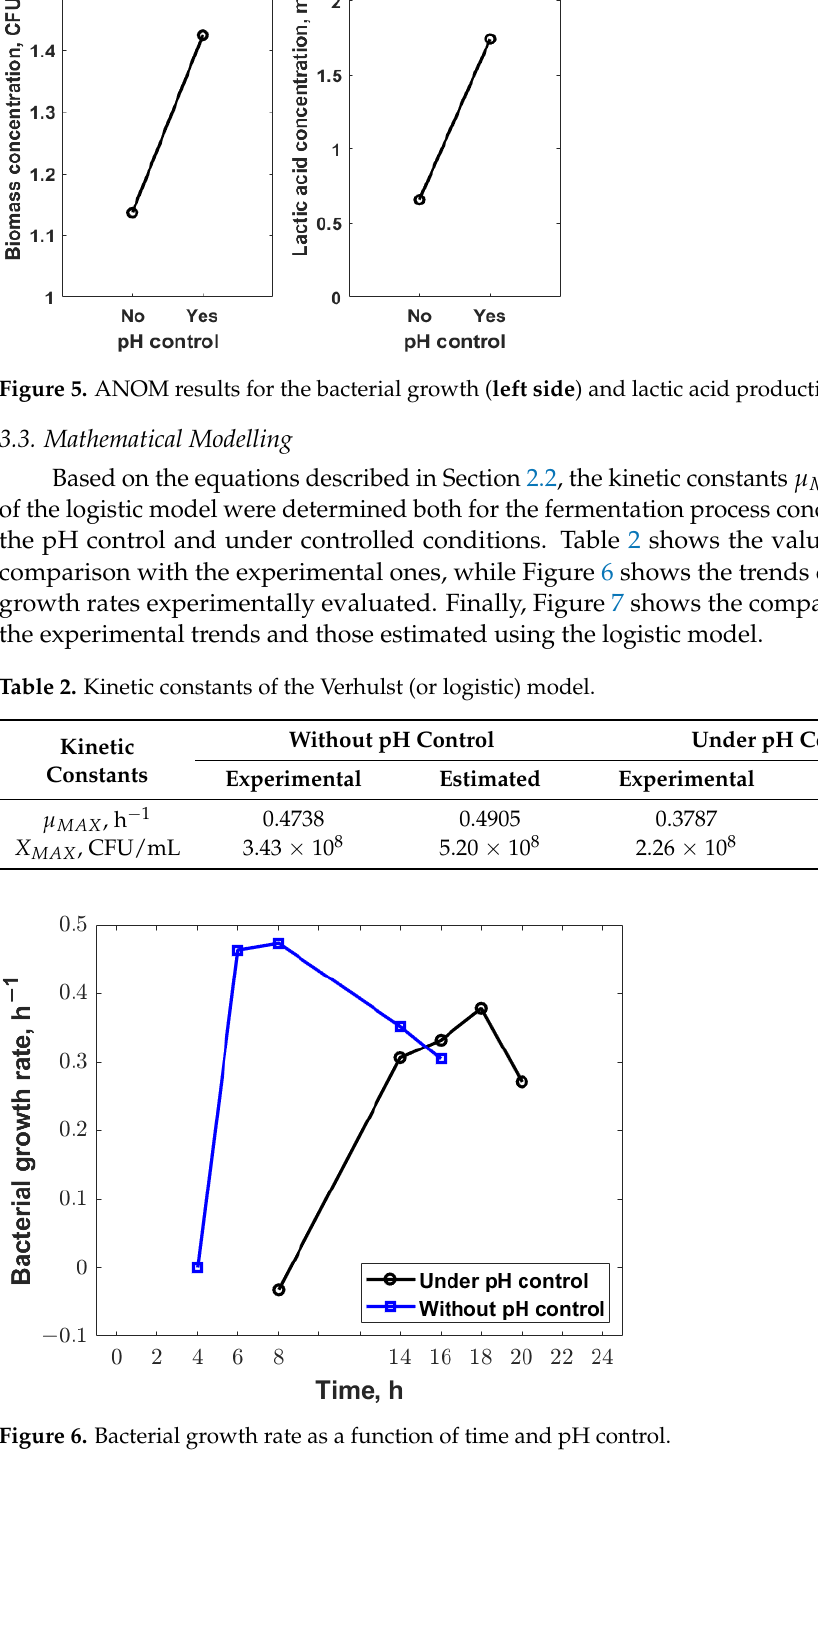
( b ) Figure 7. Trends of the bacterial growth rates estimated using the logistic model: ( a ) without and ( b ) under pH control. As can be seen from Error! Reference source not found. and Error! Reference source not found. , the logistic model is able to accurately describe the bacterial growth curve during the exponential phase only, with an R 2 of about 0.97 for both conditions studied. On the other hand, the data reported in Error! Reference source not found. suggest that the mathematical model overestimates the maximum concentration of biomass regardless of the pH control, while there is a different trend for the maximum growth rate, which is overestimated without pH control and underestimated under pH control. Despite the good predictive capabilities shown in the exponential phase, the model loses effectiveness outside this range. This may be due to the small experimental data set. It is therefore necessary to resort to more accurate methods that consider the substrate concentration and/or the inhibition effect due to fermentation saturation, or, as described in the following section, to expert methods capable of managing this lack of information and propose innovative solutions which allow the combination of parameters that are not commonly used in traditional kinetic models. 3.4. Genetic Algorithm Optimization